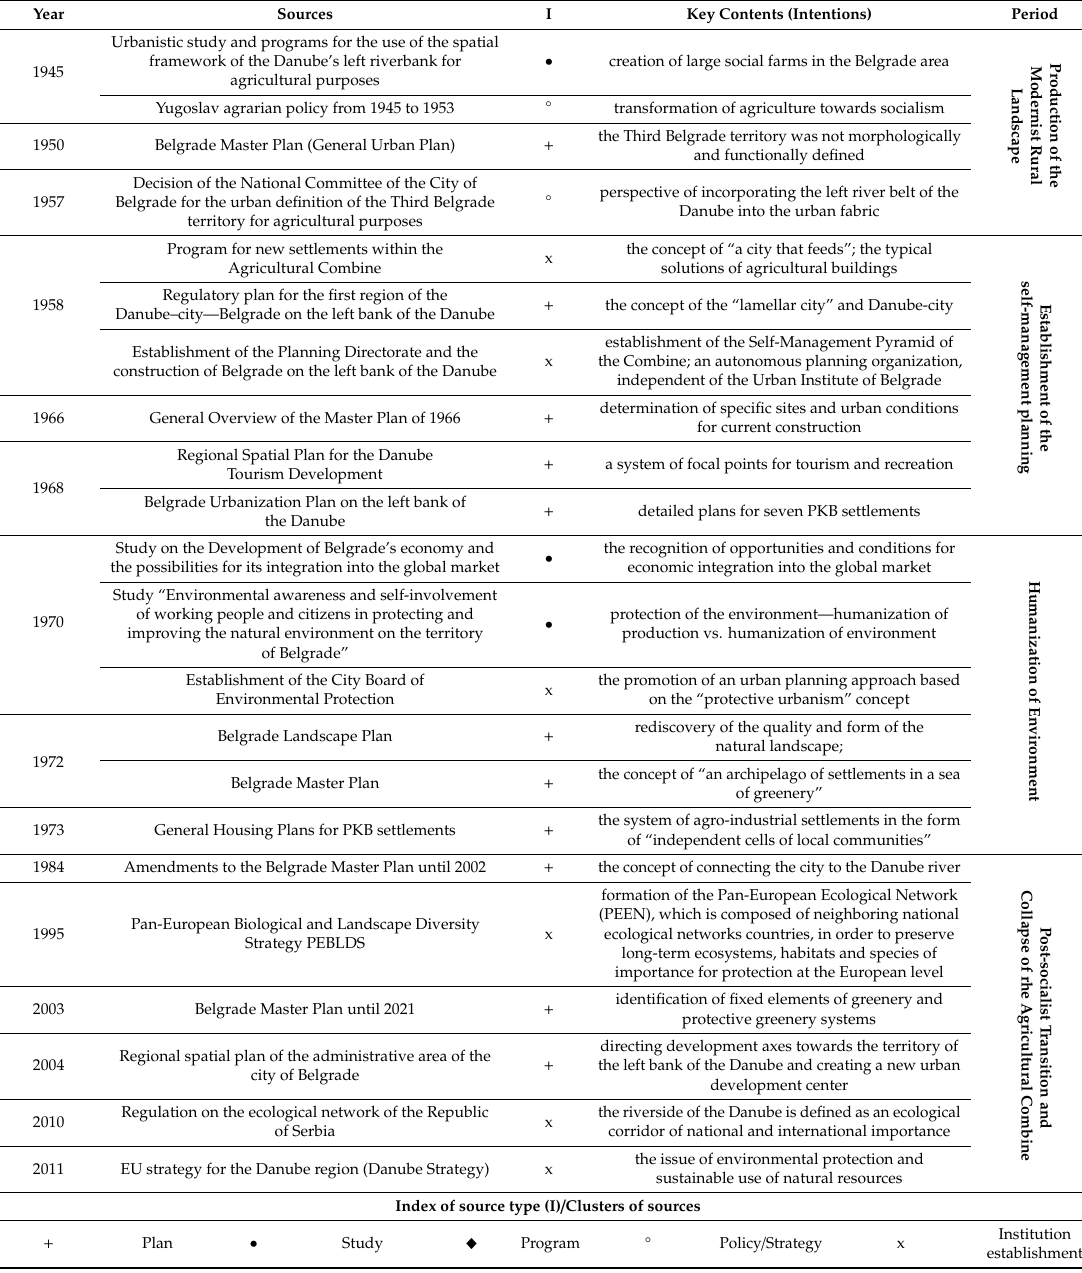
Table 1. Main sources and key contents for PKB